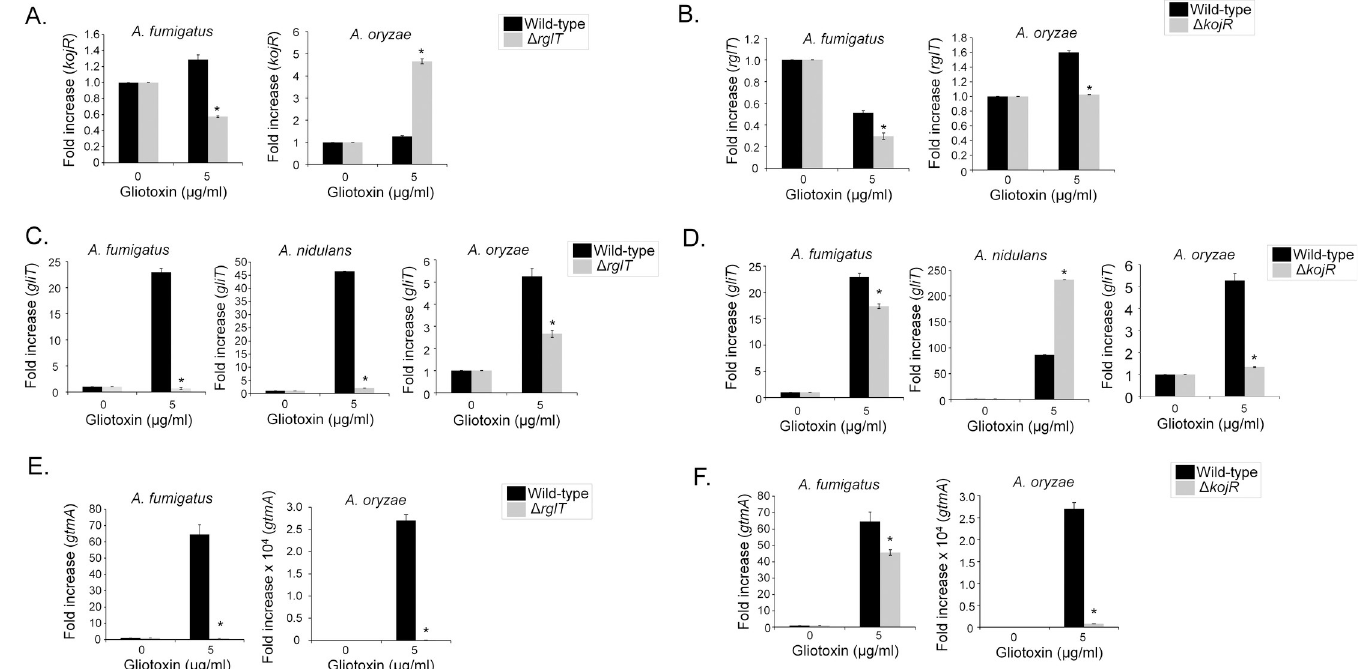
Fig 9. GliT and GtmA are dependent on Aspergilli RglT and KojR. A . fumigatus , A . nidulans , and A . oryzae strains were grown for 21 h at 37˚C before 5 μ g/ml of GT was added to cultures for 3 hours. RNA was extracted from all fungal strains, reverse transcribed to cDNA and RT-qPCRs were peformed. The expression of gtmA , kojR and rglT in the A . nidulans WT, Δ rglT and Δ kojR strains could not be measured due to either the absence of the gene ( gtmA ) or the absence of quantifyable mRNA. Results are the average of three biological replicates ± standard deviation. Statistical analysis was performed using a one-tailed, paired t-test when compared to the control condition ( � , p < 0.05). (A-D) A . fumigatus , A . nidulans , and A . oryzae wild-type, Δ rglT , and Δ kojR strains were grown for 21 h at 37˚C and mycelia was exposed to 5 μ g/ml of GT for 3 hours. RT-qPCR analysis for kojR (A), rglT (B), gliT (C and E), and rglT (D and F)